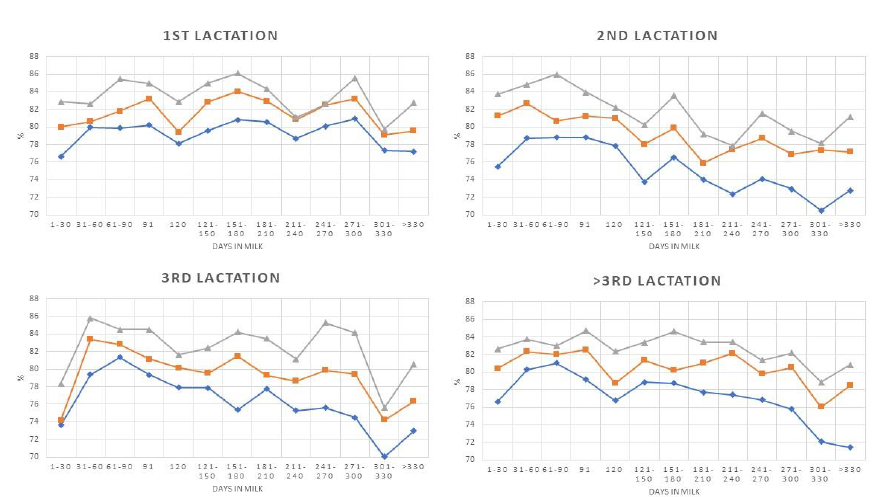
Figure 3. Differential Somatic Cell Count (DSCC) patterns during lactation classified by parity and Somatic Cell Count (SCC) level ( >200,000 cells/mL; >400,000 cells/m; >800,000 cells/mL.